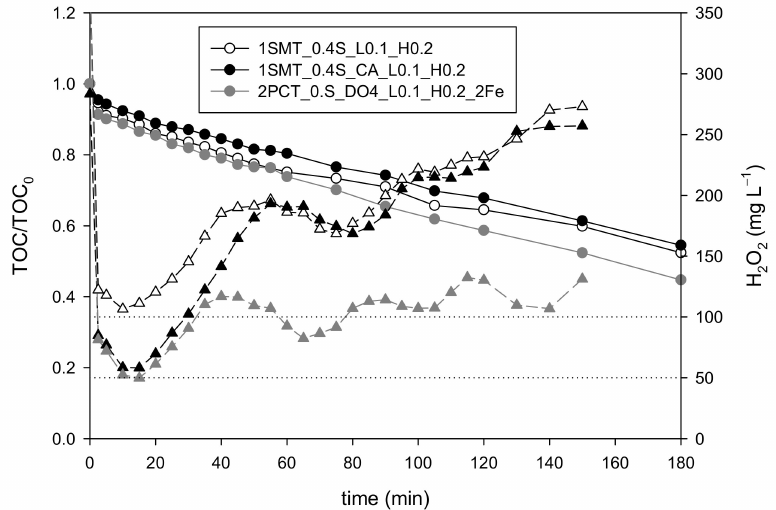
Figure 9. Comparison of different complete H 2 O 2 dosage strategies for the treatment of 2PCT contaminated wastewater (126 mg L − 1 TOC) by photo-Fenton process (TOC and H 2 O 2 concentration profiles are represented by round and triangular symbols,